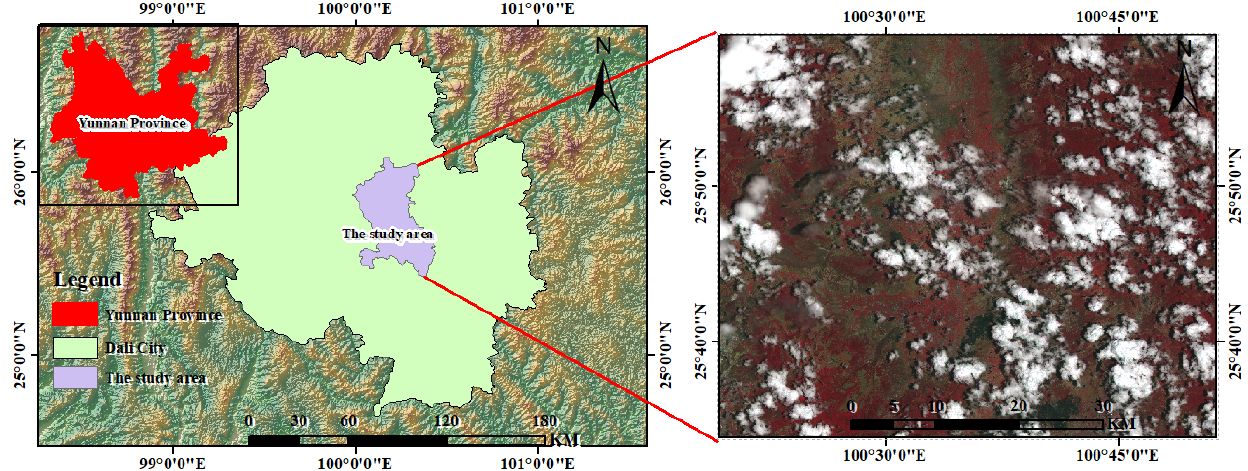
Figure 1. The location of the study area. The image of the right column in false color composition (red: band 8; green: band 4; blue: band 3) is derived from the Sentinel-2 image acquired on 2 February 2018.